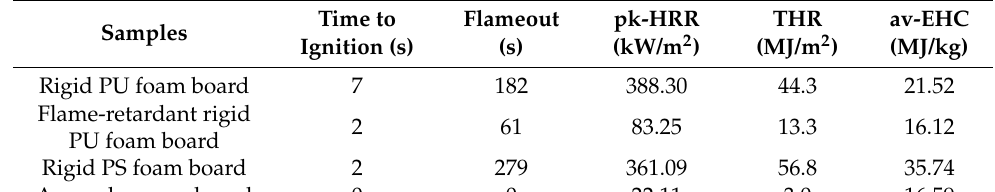
Table 3. Combustion parameters obtained from the cone calorimeter.